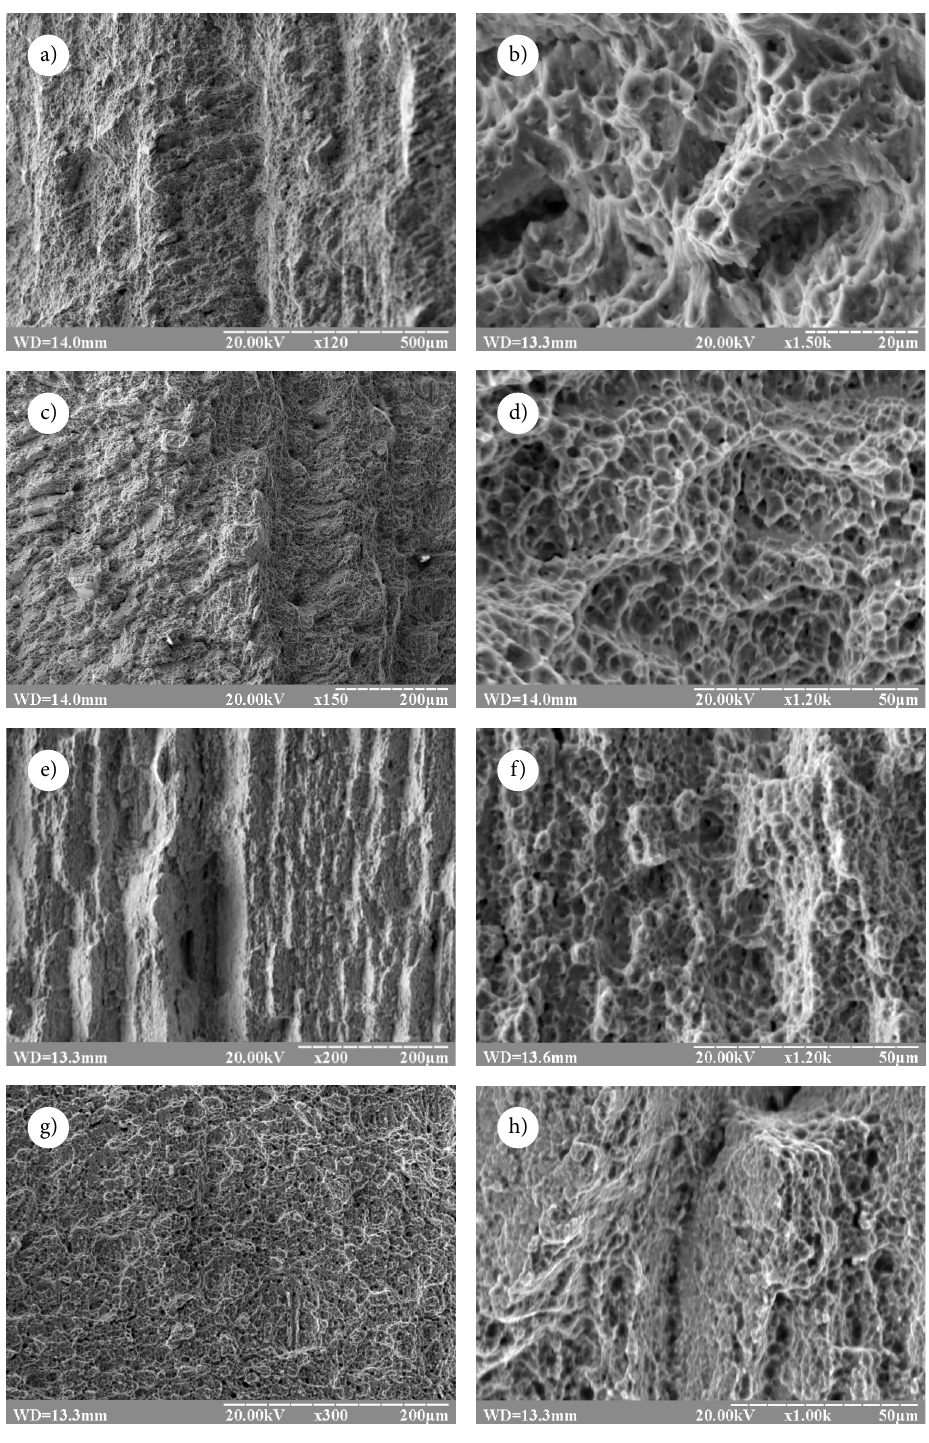
Fig. 12. Scanning Electron Microscope (SEM) images of fracture of alloy VT22 after: a, b – ST; c, d – ST + DNP ( F imp = 60 kN) + ST; e, f – HLN + ST; g, h – DNP ( F imp = 60 kN) before the yield point of the alloy + HLN